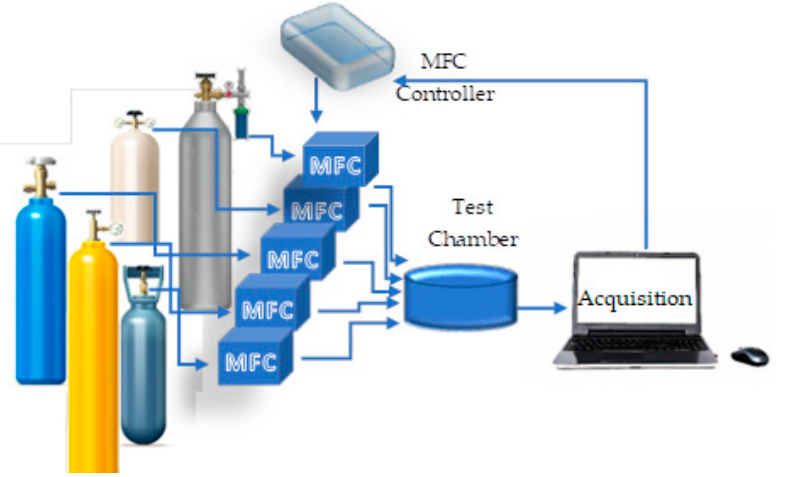
Figure 1. Diagram of the testing setup. Five gas cylinders containing the gases of interest, nitrogen and two other pollutants (CO and CH 2 O) are connected to the testing chamber via multi-channel mass flow controllers (MFCs)). The MFCs, via a feedback loop with the acquisition computer, can control the composition of the mixture that is to arrive in the test chamber. A more detailed image of the testing setup can be found in Figure S2.